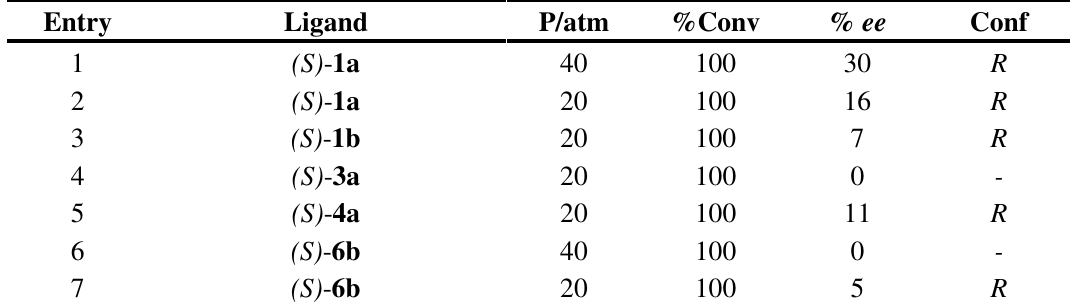
Table 3. Hydrogenation of 2-methylquinoline in presence of iodine.